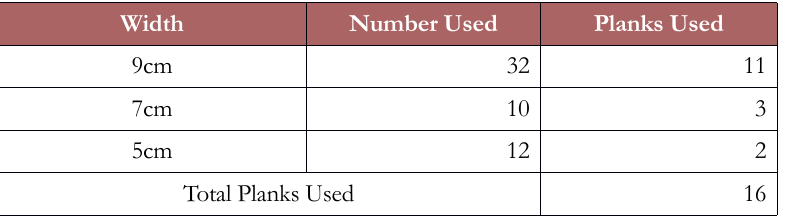
Table 3. Number of stock length used by current practice to produce the